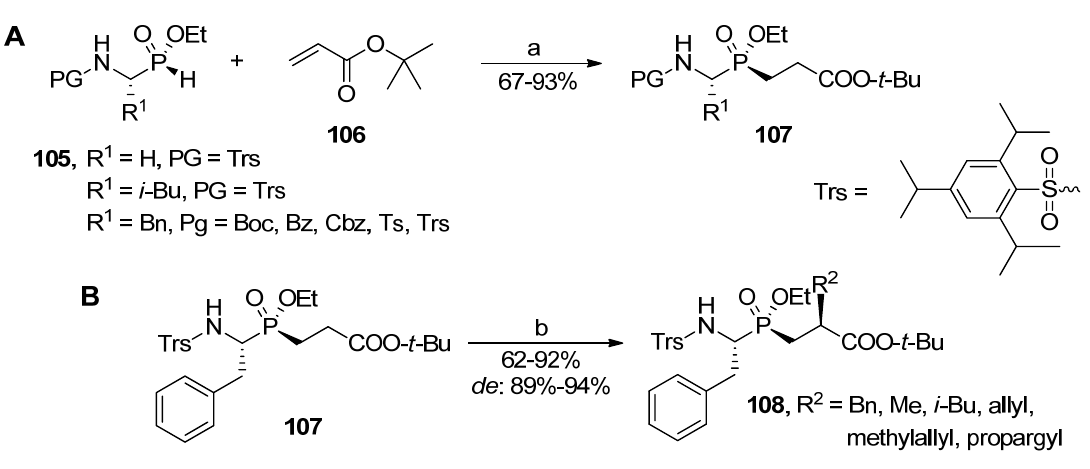
resulting phosphinate dipeptide controlled by the defined phosphorus atom